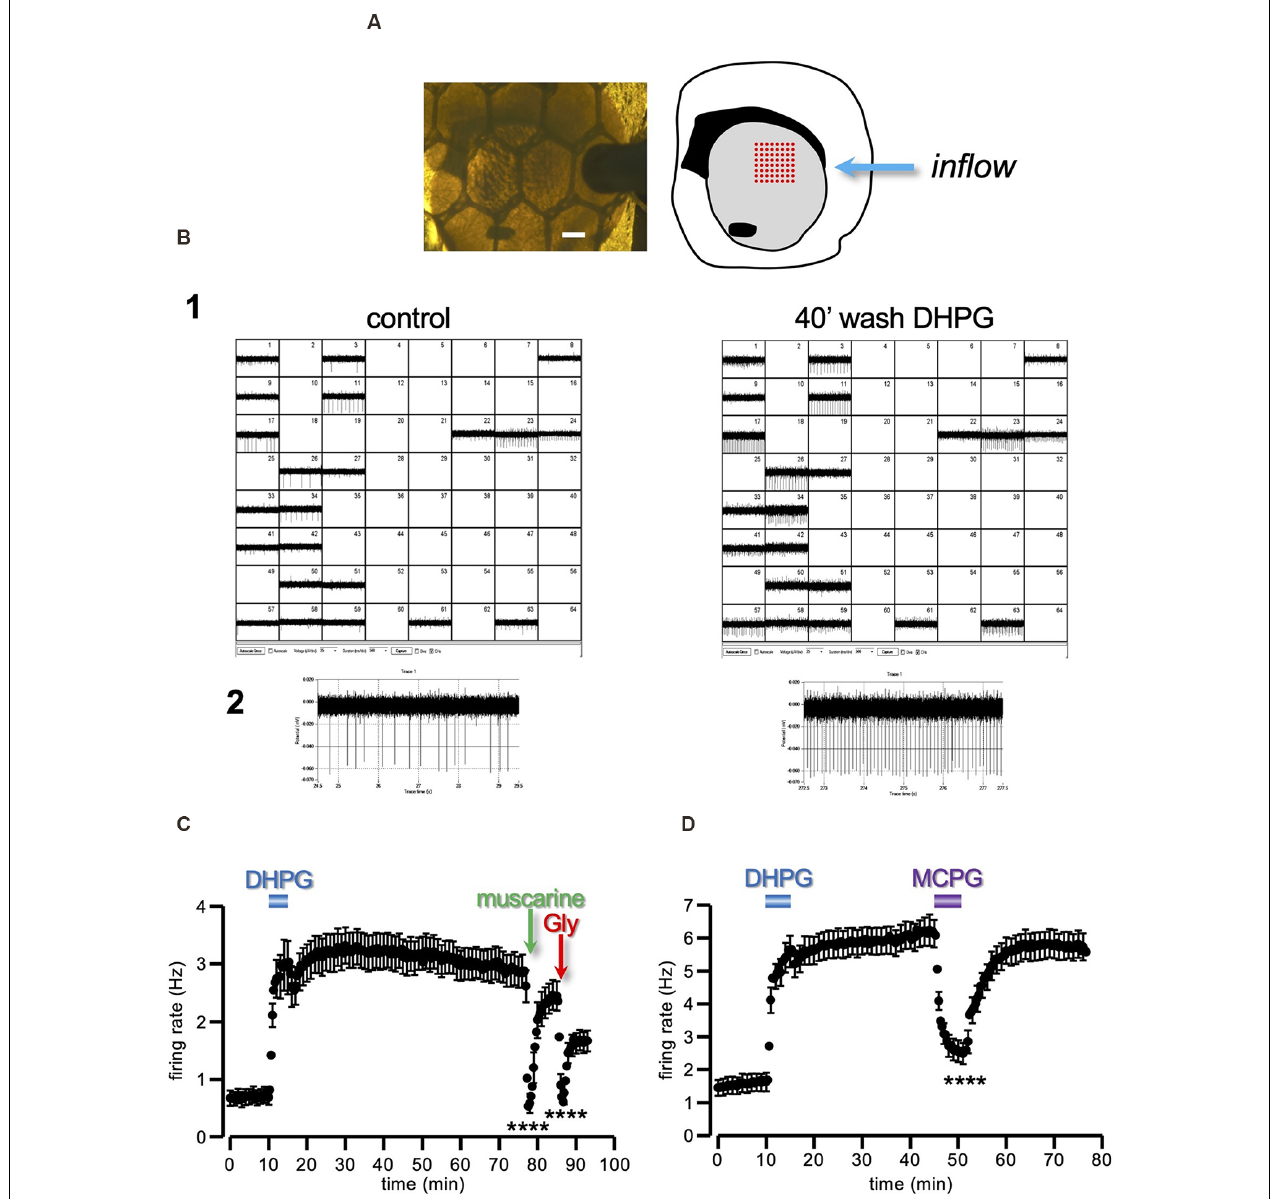
FIGURE 4 | Long-lasting enhancement of ChIs firing induced by DHPG. (A) Photograph of a coronal striatal slice covered by a nylon mesh and continuously perfused by aCSF, with its schematic drawing on the right. The slice was placed in an MEA recording chamber over an 8 × 8 array of planar electrodes (red dots in the drawing representation), in such a way as to cover the dorsal portion of the striatal area (grey area of the drawing representation). Scale bar 0.5 mm. (B1) Out of the total 64 channels, only those containing repetitive fast deflections, indicative of spontaneous action potentials, were selected for analysis (22 channels in